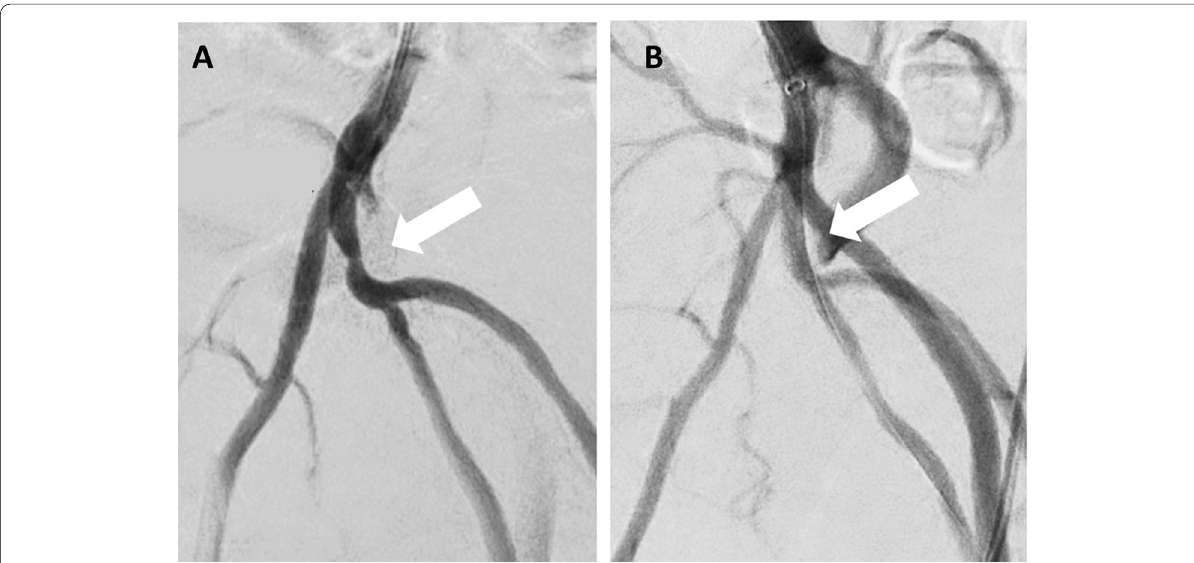
Fig. 4 Stenosis of the right internal pudendal artery before ( A ) and after ( B ) stenting in the same